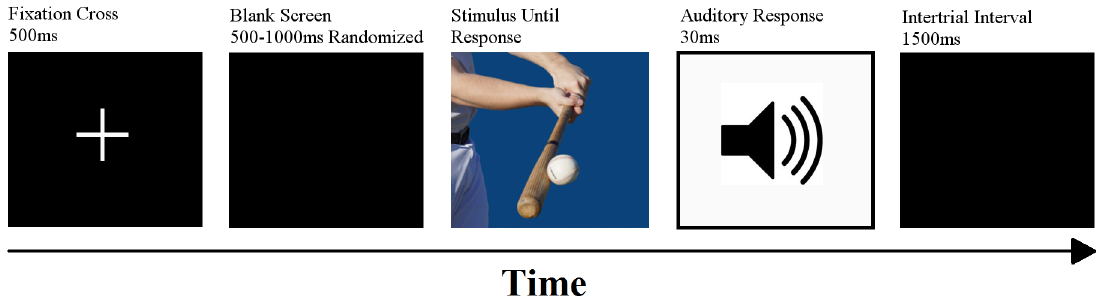
Fig 2. Order of CRT Stimuli. Example of a CRT trial depicting the order and time length of each element of the